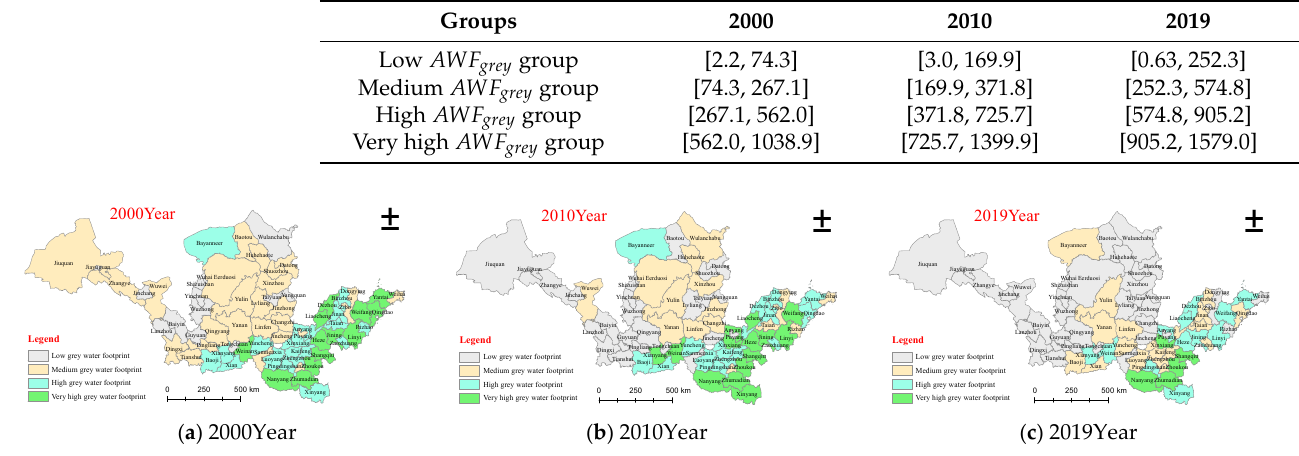
Figure 4. Spatial distribution of the 𝐴𝑊𝐹 (cid:3034)(cid:3045)(cid:3032)(cid:3052) in the Yellow River Basin from 2000 to 2019. 3.2. Spatial and Temporal Characteristics of the 𝐴𝑊𝐹 (cid:3034)(cid:3045)(cid:3032)(cid:3052) in the Yellow River Basin This study calculated the global autocorrelation Moran’s I index of the 𝐴𝑊𝐹 (cid:3034)(cid:3045)(cid:3032)(cid:3052) of cities in the Yellow River Basin from 2000 to 2019. Due to space limitations, only the global Moran’s I index for 2000, 2010, and 2019 is shown (Figure 5). The 𝐴𝑊𝐹 (cid:3034)(cid:3045)(cid:3032)(cid:3052) of the Yellow River Basin has shown a significant positive correlation in the past 20 years, that is, the areas with a high 𝐴𝑊𝐹 (cid:3034)(cid:3045)(cid:3032)(cid:3052) are adjacent and the areas with a low 𝐴𝑊𝐹 (cid:3034)(cid:3045)(cid:3032)(cid:3052) are also adja- cent, showing obvious spatial agglomeration. The value of Moran’s I from 2000 to 2019 decreased slightly with the change in years, from 0.494 to 0.449, indicating that with the continuous development of the agricultural economy in the Yellow River Basin, the de- velopment speed of different regions has been inconsistent and the gap large. Therefore, the spatial agglomeration degree of the 𝐴𝑊𝐹 (cid:3034)(cid:3045)(cid:3032)(cid:3052) has been slightly weakened.